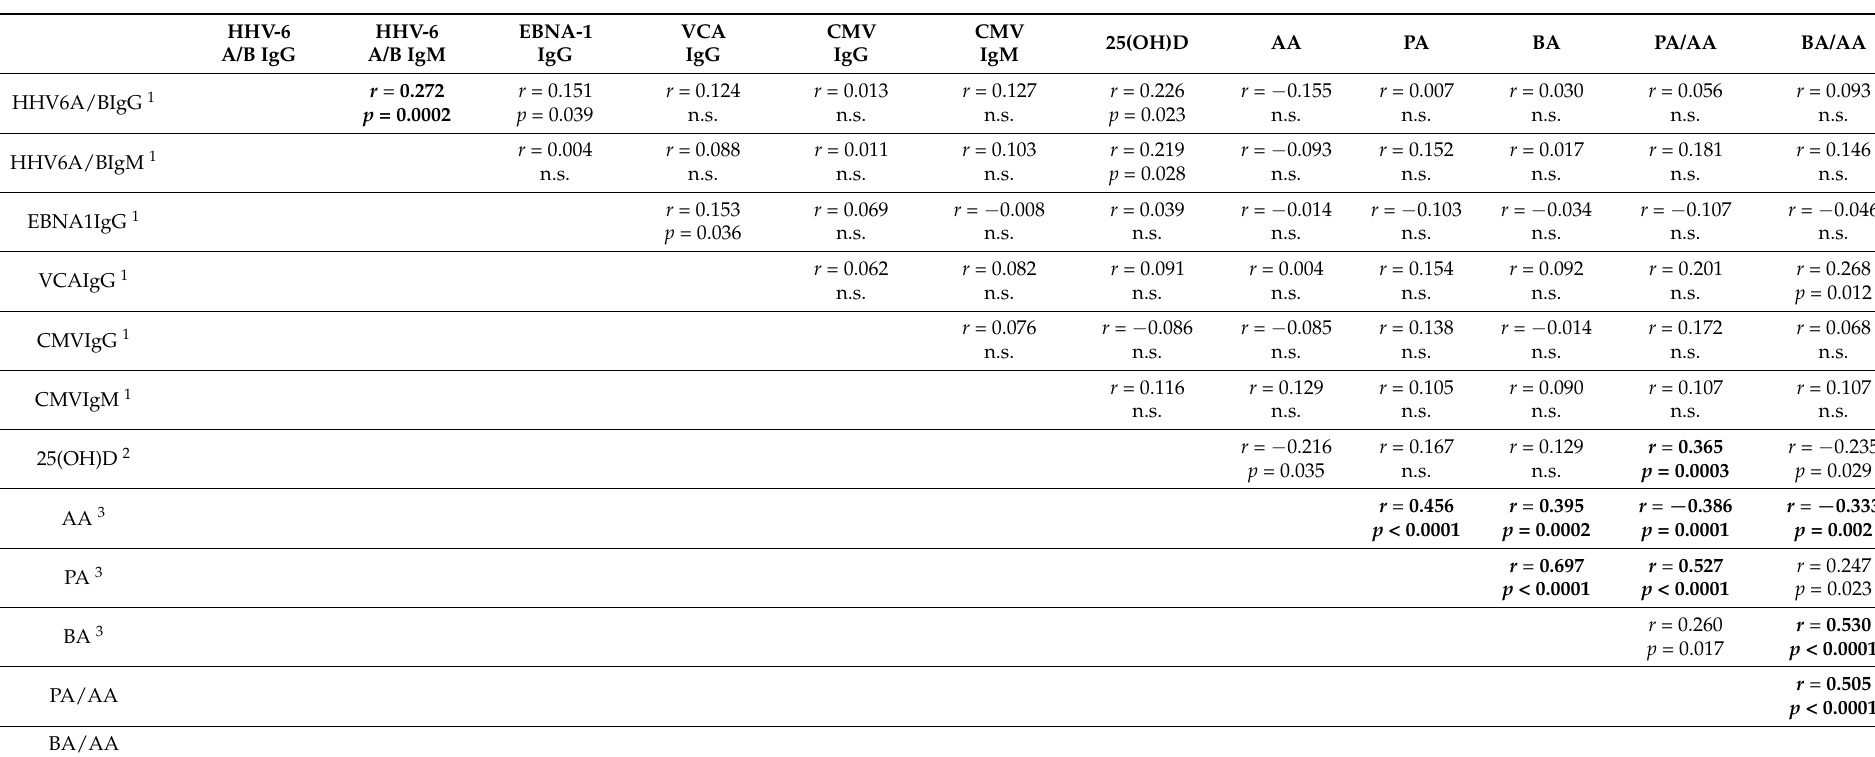
Table 4. Correlations among the environmental factors analyzed in samples collected from MS